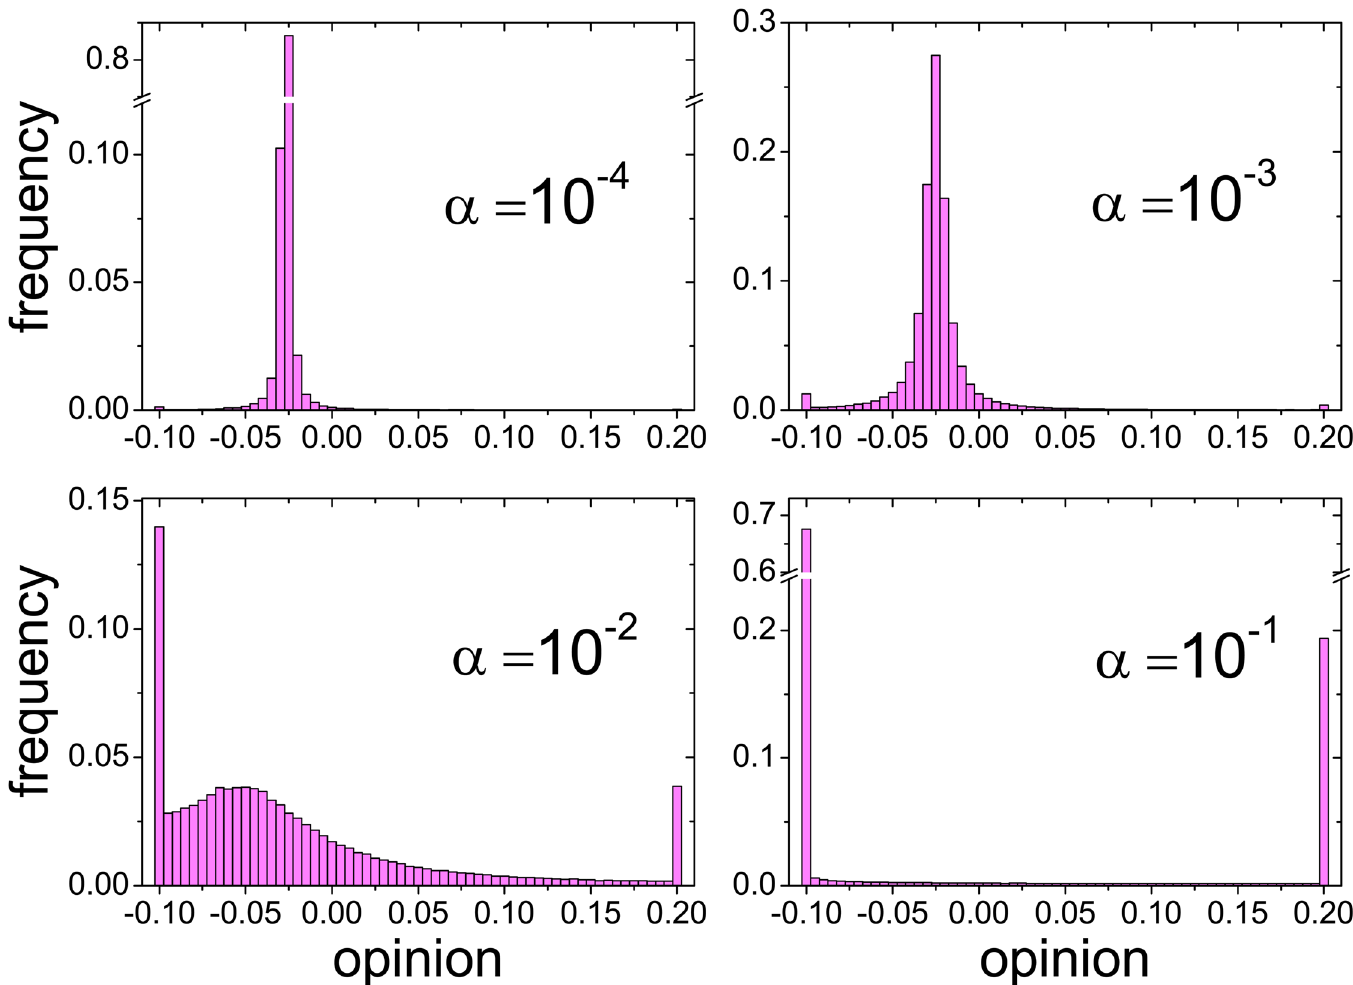
Fig 5. Opinion distributions under the influence of two leaders. The histograms show simulation results for the stationary distribution of opinions in a population of 10 4 agents, with the same initial condition as in Fig 4. The leaders have fixed opinions R 1 = 0.2 and R 2 = − 0.1, and they are chosen as references with frequencies α 1 = α and α 2 = 4 α , respectively. The four panels correspond to different values of α , as indicated by the labels. The leaders ’ influence is such that, upon interaction with a leader, ordinary agents always adopt the leader ’ s